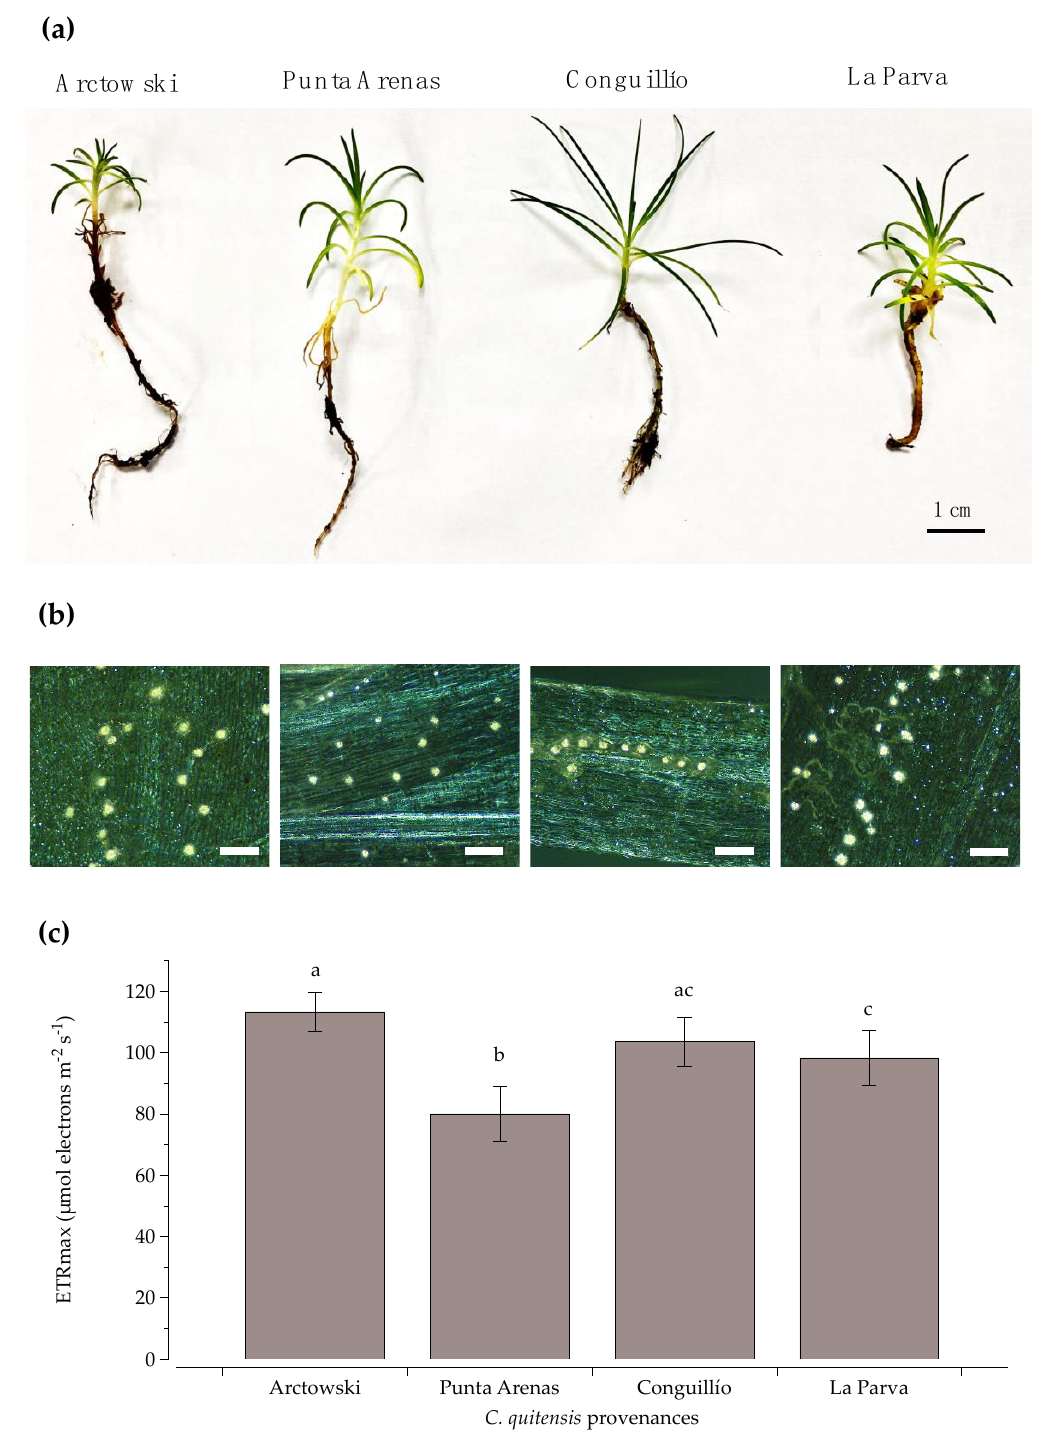
Figure 1. Anatomical and photosynthetic traits of four Colobanthus quitensis provenances ( a ) A habit from the four provenances of C. quitensis , from left to right showing a south-north pattern.; ( b ) Paradermal view of the chlorine-bleached leaves from four provenances of C. quitensis under polarized light (10X). CaOx crystals are visible as bright spots. The micrographs follow the same provenances pattern as in ( a ). The white scale bar: 200 µm.; ( c ) Maximum electron transport capacity (ETRmax) at light saturation from the four provenances of C. quitensis. Plants were grown under common garden conditions. Error bars denote SE of mean; n = 10. Different letters represent statistically significant differences between provenances (one-way ANOVA; p < 0.05).